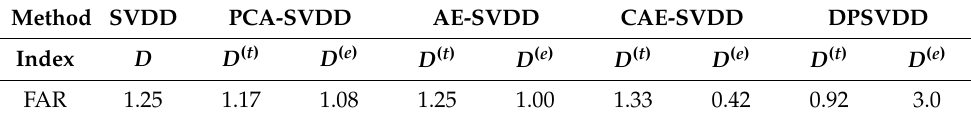
Table 4. False alarm rates (FARs)(%) of the six tested faults by the five compared